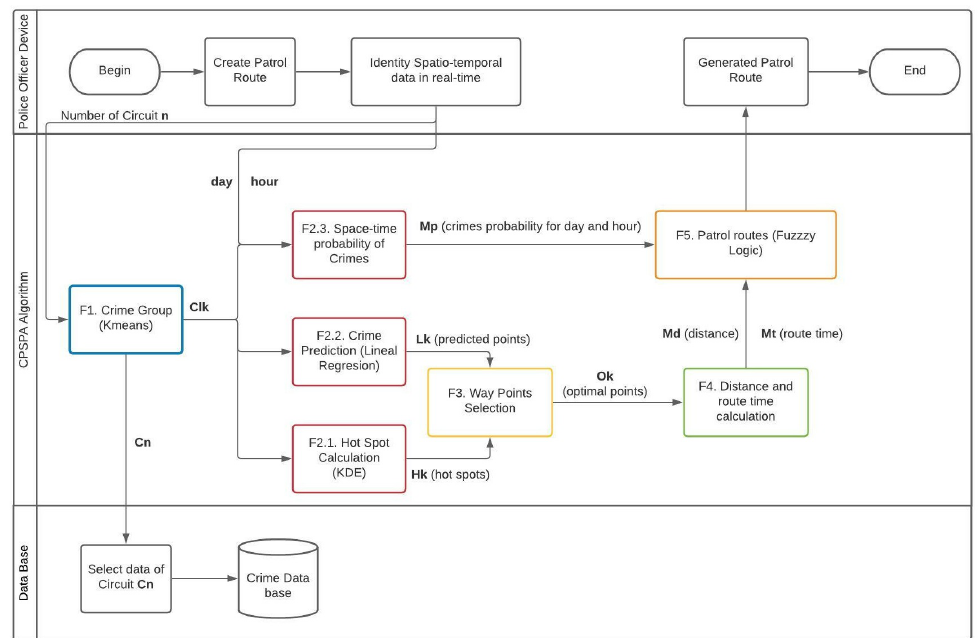
Figure 6. Activity diagram UML of Smart Patrol and Crime Prediction